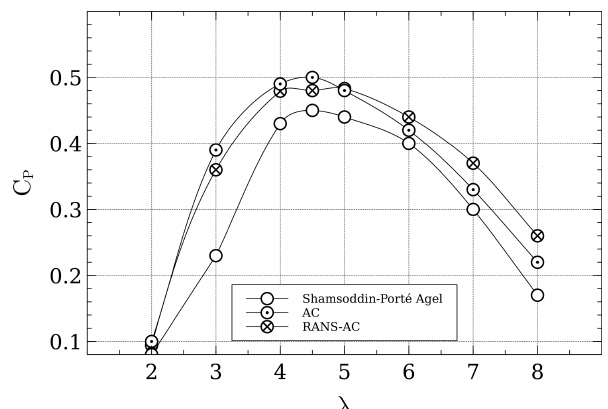
Figure 14. Comparison of C P results from an LES simulation with the current RANS-AC. The turbine’s σ is